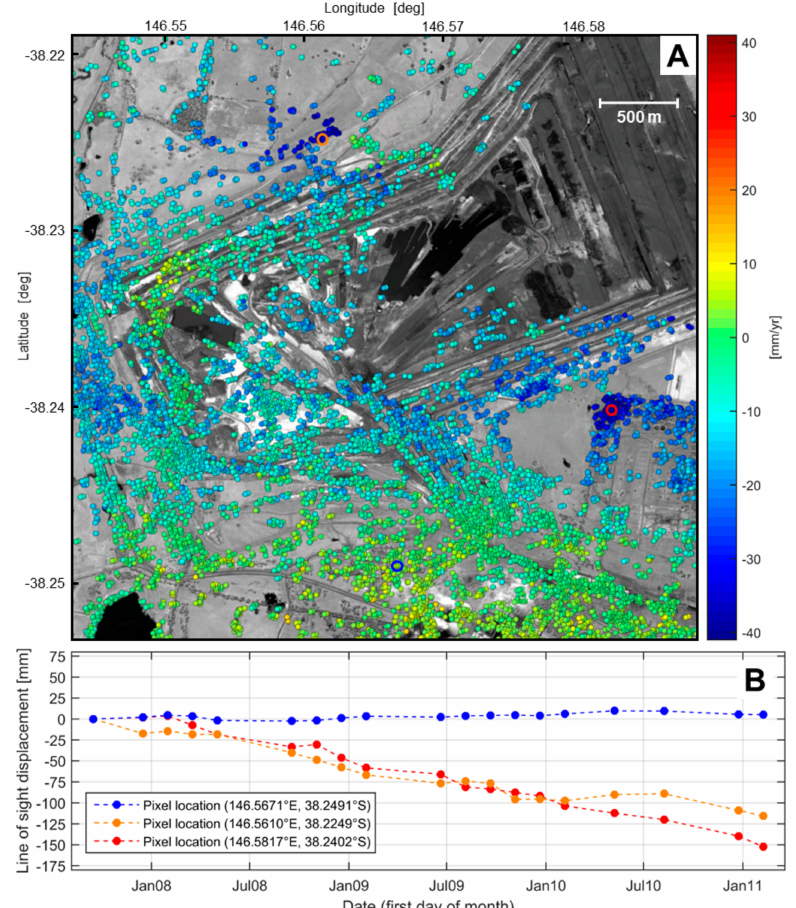
Figure 7. LoS velocities at the Loy Yang mine in the Latrobe valley, Victoria, derived from the InSAR analysis of ALOS PALSAR between 20070915 and 20110812. ( A ) Average LoS velocities overlain on a background Google Earth image from 20110812. The coverage of coherent pixels is limited by the rapid displacements and satellite imaging geometry. ( B ) Time-series shows the time history of LoS displacements at three pixels located outside of the open-cut operations area, and these pixels are highlighted in A with